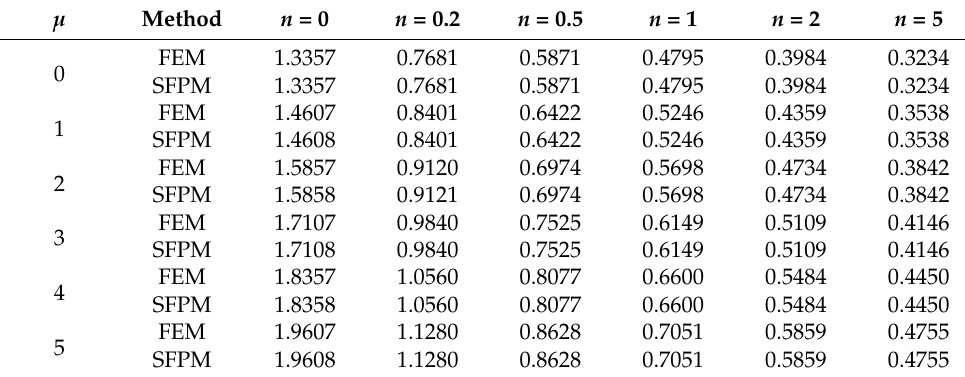
Table 3. Comparison of the dimensionless deflection of the FGM nanobeam, calculated by FEM and SFPM.